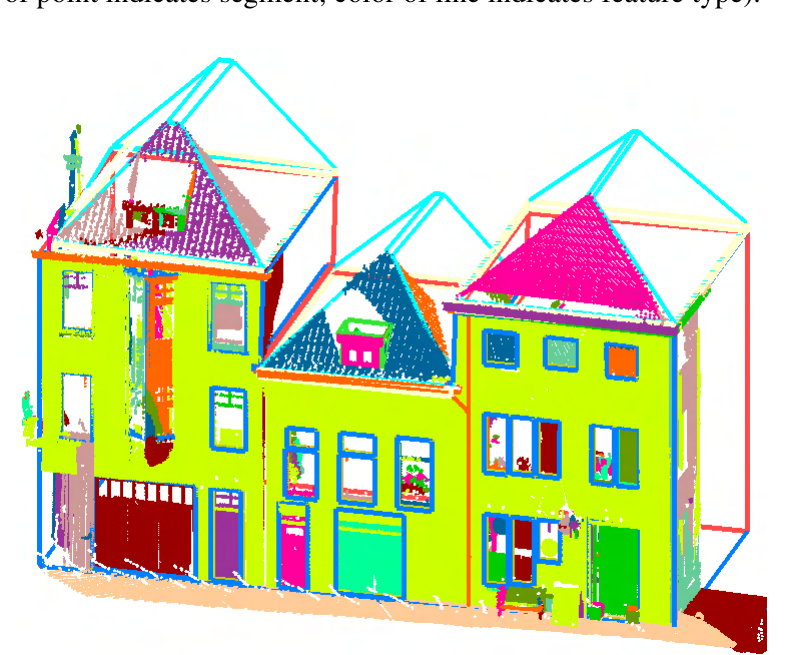
Figure 2. A reconstructed building facade model, shown together with segmented laser points (color of point indicates segment; color of line indicates feature